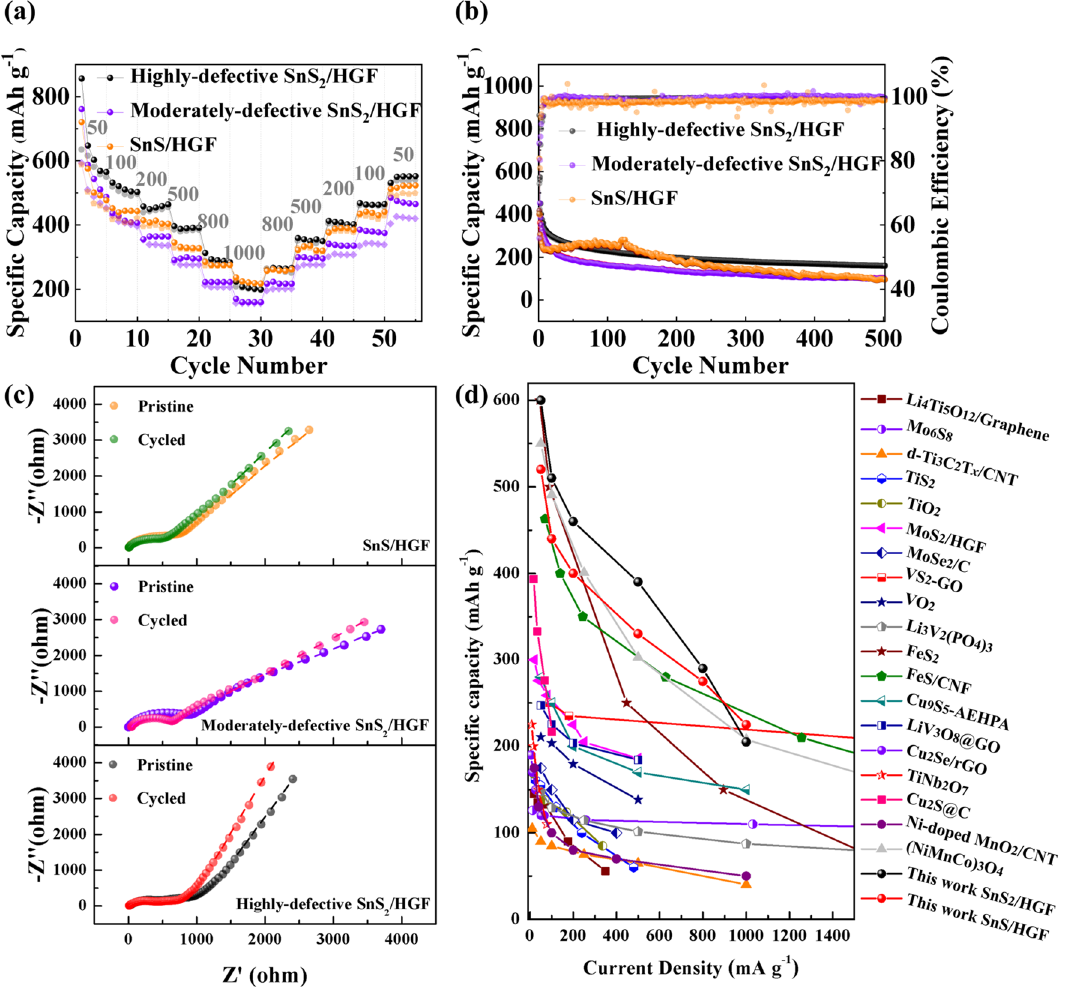
Fig. 5 Electrochemical performance of highly defective SnS 2 /HGF, moderately defective SnS 2 /HGF, and defect-free SnS/HGF in MLHB. a rate performance, b cycling stability at 800 mA g. −1 , c Nyquist plots at the OCP before and after cycling (the dotted lines are fitting curves using the equivalent circuit shown in Fig. S7h), and d rate capability in comparison with those reported in the literature